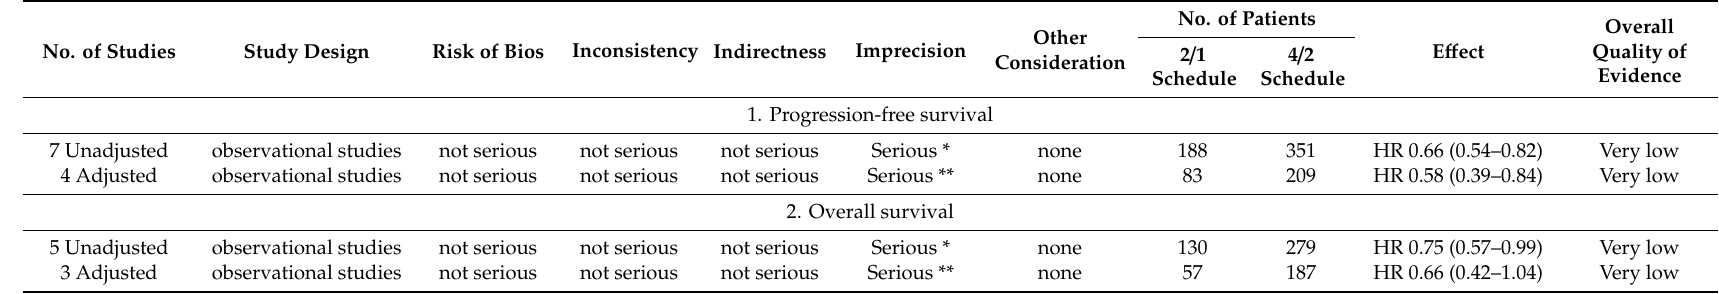
Table 3. Results of the GRADE (Grading of Recommendations, Assessments, Developments, and Evaluation) quality assessment of direct evidence of each comparison.